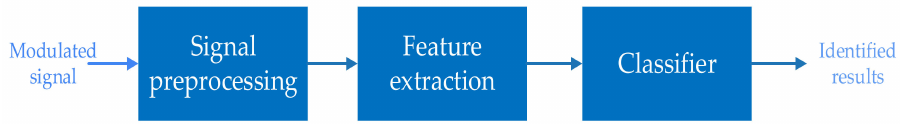
Figure 3. Flowchart of the characteristic modulation identification